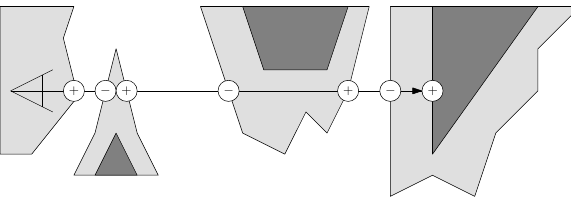
Figure 4: The eye ray possibly exits (+) and reenters (-) the inte- rior of the near surface (light gray) multiple times before hitting the far surface (dark gray).